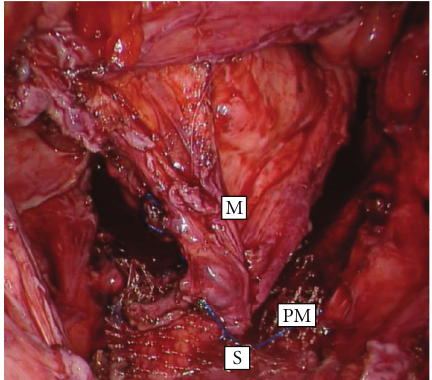
Figure 2: Suture rectopexy with mesh securing the mesentery of the pouch to the presacral fascia in the deep pelvis. The mesentery of the pouch (M), sacral promontory (S), and non-absorbable prolene mesh (PM) are